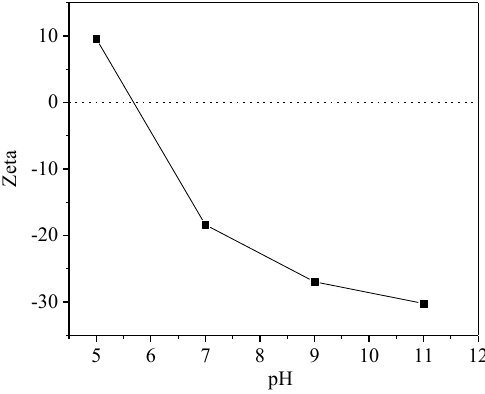
Figure 8. Zeta potential of HA-antibiotic systems under different pH conditions.